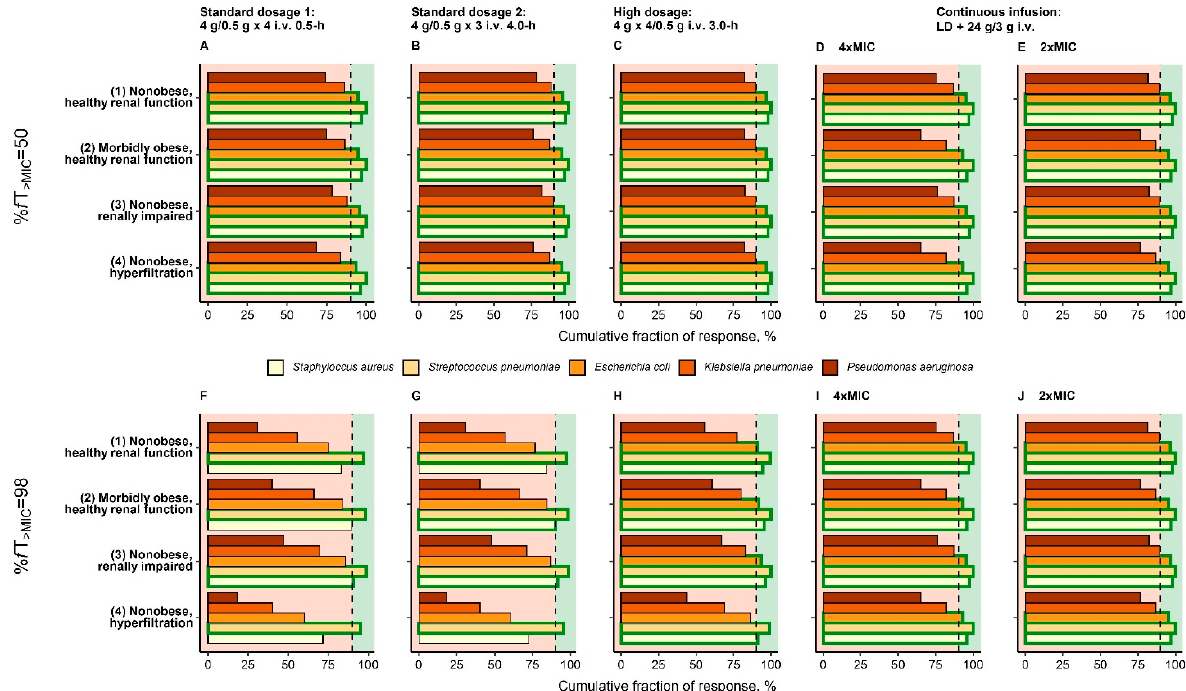
Figure 3. Cumulative fraction of response for virtual reference patients (see Table 1) receiving three dosing regimens recommended by EUCAST ( A / F , B / G , C / H ) and one continuous infusion dosing regimen ( D / E , I / J ) based on the EUCAST species-specific distributions of MIC. Vertical dashed black line: Separation of CFR < 90% (inadequate therapy) and CFR ≥ 90% (adequate therapy); Bars bordered by green line: CFR ≥ 90% for bacterial species. Abbreviations: % f T >MIC : Fraction of time that unbound concentrations exceed MIC over 24 h; CFR: Cumulative fraction of response; EUCAST: European Committee on Antimicrobial Testing; i.v.: Intravenous; MIC: Minimum inhibitory concentration.